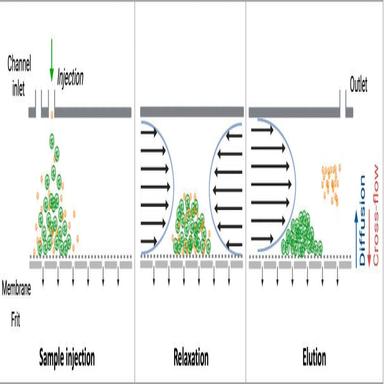
Schematic illustration of the AF4 working principles (cross-sections of the thin channel). The three main steps are: sample injection, relaxation, and elution. (Created with (http://BioRender.com)).